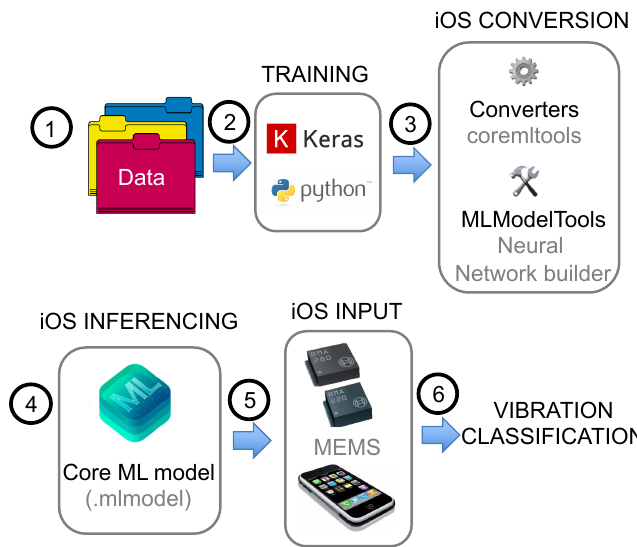
Figure 16. Core ML integration into smartphones for real-time vibration